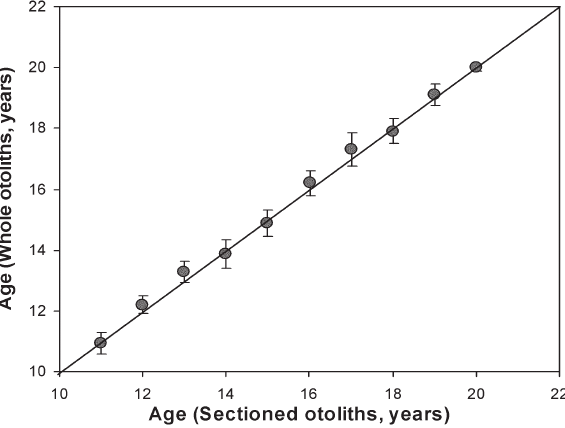
Fig. 5. – age bias plot for ageing whole otoliths and sectioned oto- liths of Mycteroperca fusca . each error bar represents the standard deviation and circle the mean value. the 1:1 equivalence (solid line) is also indicated.